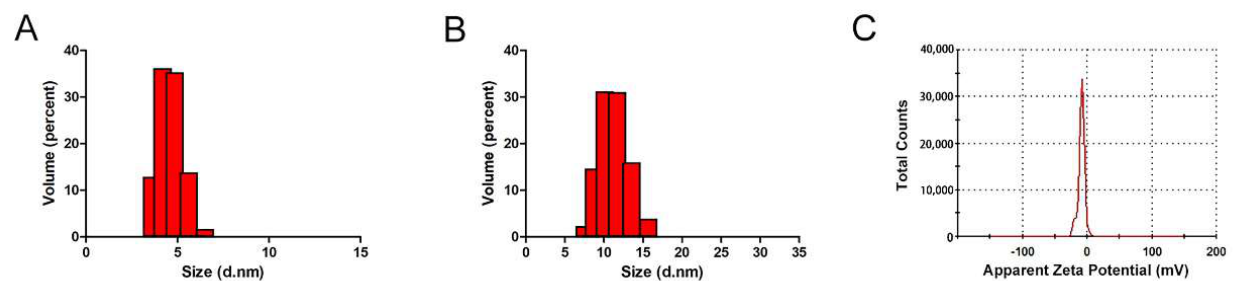
Figure 3. Characterization of BSA-Apt. Size distributions of free PD—L1 aptamers ( A ) and BSA—Apt ( B ). Zeta potential distribution of BSA—Apt ( C ).